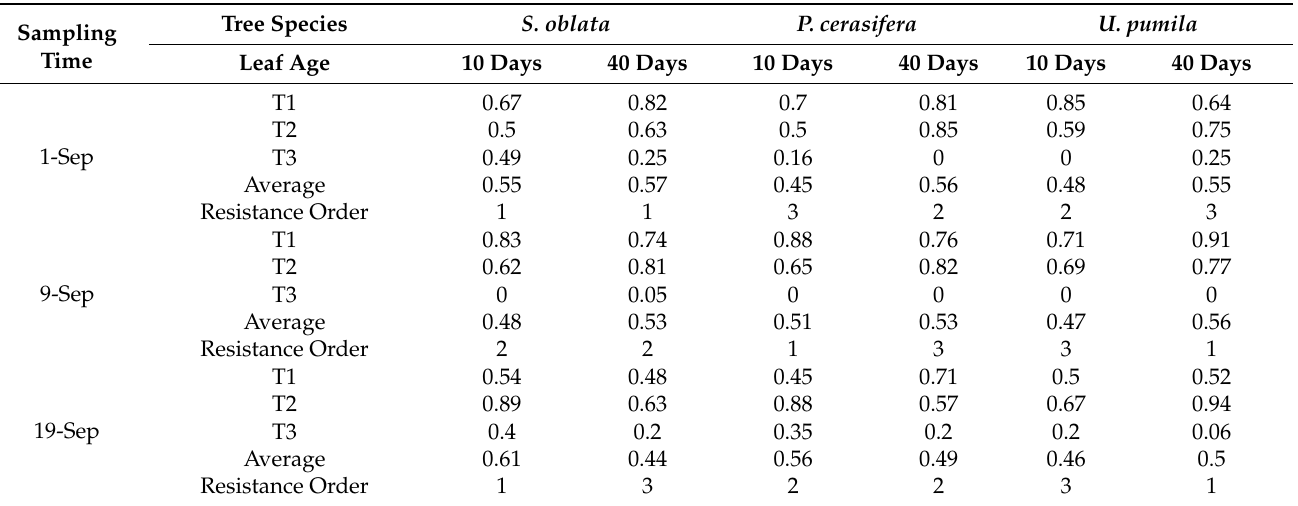
Table 6. Function value of subordination and the comprehensive judgment on SO 2 resistance of the three tree species.